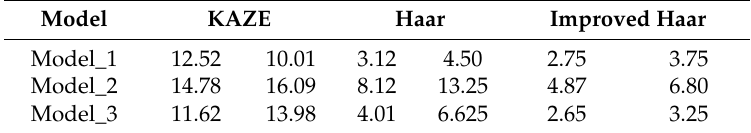
Table 1. Comparison of average pixel errors under different illuminations by three matching algorithms.